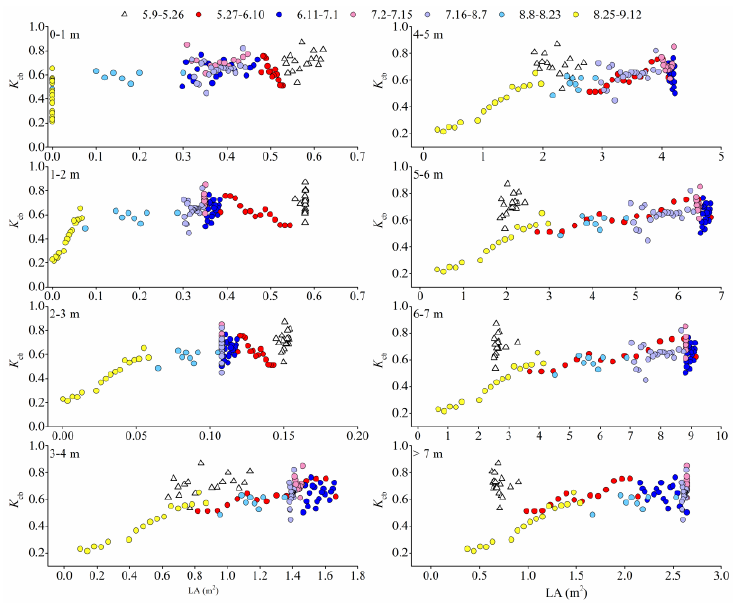
Figure 10. Variation of the crop coefficient ( K cb ) of the sample tree with leaf areas (LA) in different canopy layers. The date format in different periods is